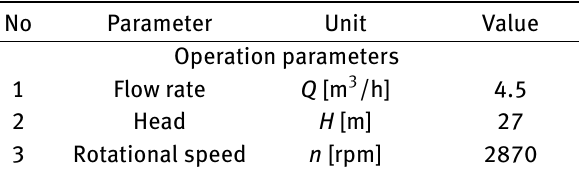
Table 1: Design parameters of the